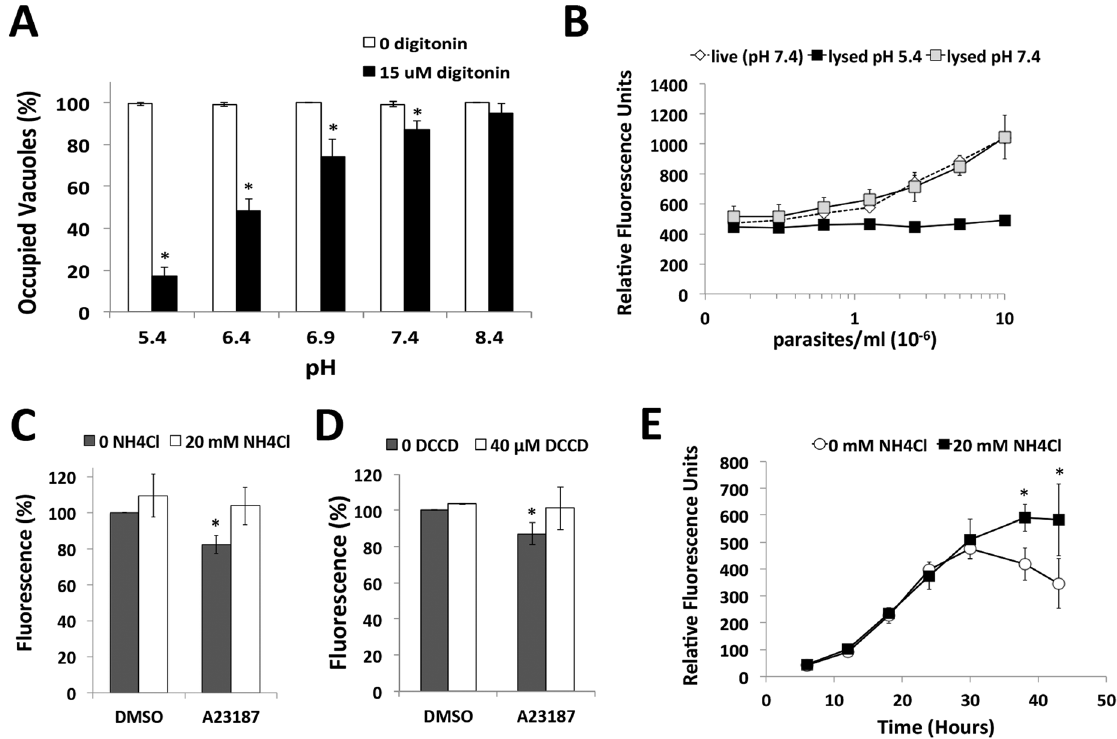
Figure 2. Acidic pH induces parasite egress and pH shifts occur upon egress induction, and late in the replication cycle. (A) Parasite egress quantified by immunofluorescence microscopy. 30 h vacuoles were treated with high K + buffer 6 15 m M digitonin at 37 u C for 3 min prior to fixation and egress enumeration. * p , 0.05 vs. pH 8.4 by student’s t -test. Graph indicates the average and standard deviation of 3 independent experiments. (B) Superecliptic pHuorin signal is quenched at low pH. HFF cells were inoculated with increasing doses of superecliptic pHluorin expressing plp1ko parasites ( plp1ko sepH) and fluorescence was observed 30 h post-infection in live cells or cells detergent lysed at pH 5.4 or 7.4. (C, D) A moderate decrease in pH occurs during induced egress. HFF inoculated with plp1ko parasites expressing superecliptic pHluorin for 30 h before treatment with DMSO or A23187 with or without 20 mM NH 4 Cl (panel C) or 40 m M DCCD (panel D). Results indicate the average and standard deviation of triplicate wells and are representative of 3 independent experiments for NH 4 Cl and 2 independent experiments for DCCD. * p , 0.05 vs. DMSO by student’s t -test. (E) pH changes during parasite replication. Fluorescence signal without or with 20 mM NH 4 Cl was followed for plp1ko expressing superecliptic pHluorin over the course of intracellular replication. The graph indicates the mean and standard deviation of triplicate wells and is representative of two independent experiments with independent clones. * p , 0.05 vs. 0 mM NH 4 Cl by student’s t -test.